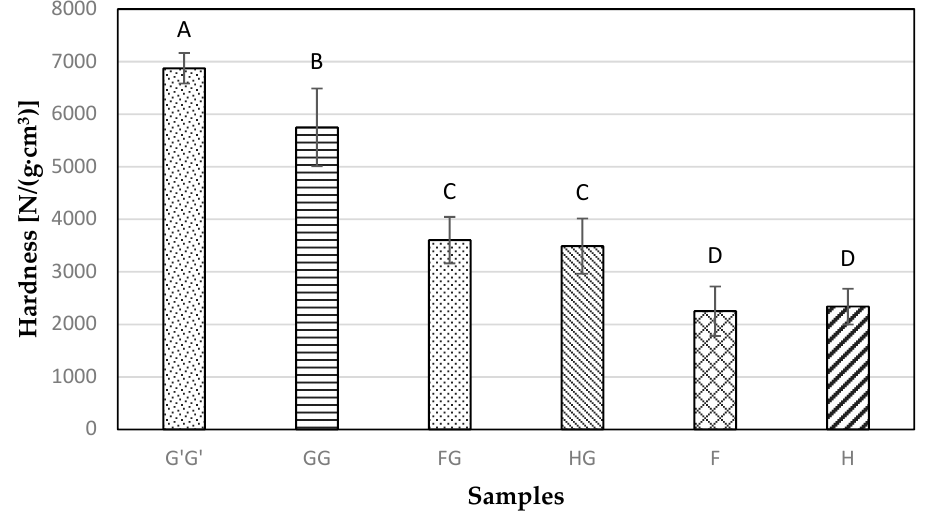
Figure 12. Specific hardness testing results obtained for composite samples containing commercial Glass fiber alone (G’G’), Glass fiber alone (GG), Flax and Glass fiber (FG), Hemp-agave and Glass fibers (HG), Flax fiber alone (F), and Hemp fiber alone (H) using Janka ball.